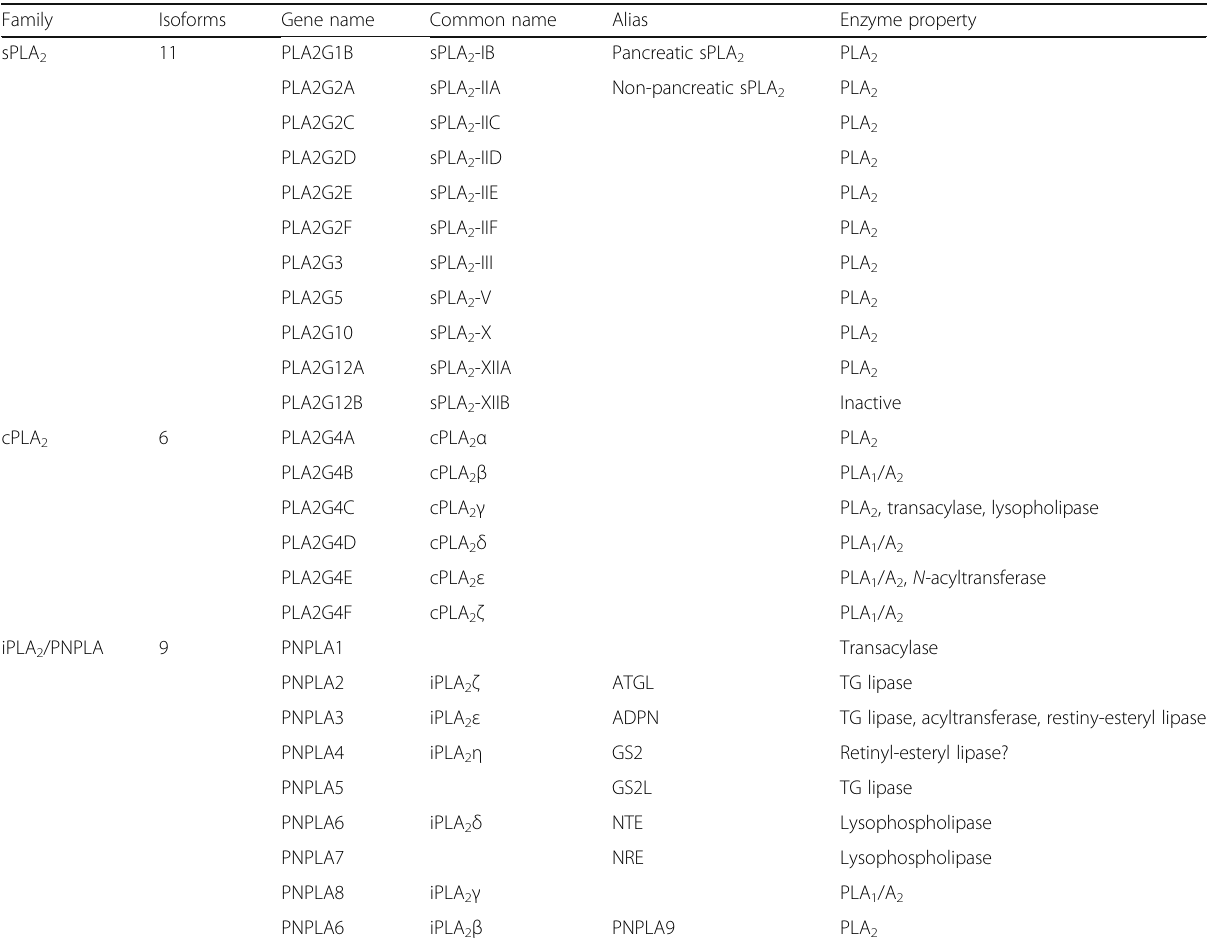
Table 1 The classification of PLA 2 family. sPLA 2 , cPLA 2 , and iPLA 2 /PNPLA are the original big three among the PLA 2 family. The sPLA 2 family contains 10 catalytically active isoforms (IB, IIA, IIC, IID, IIE, IIF, III, V, X, XIIA) and 1 inactive isoform (XIIB) in mammals. The cPLA 2 family comprises 6 isoforms ( α - ζ ). The human genome encodes 9 iPLA 2 enzymes. These enzymes are now more generally referred to as PNPLA (1 – 9). In this review, the biological roles of particular PLA 2 s in the context of skin homeostasis and diseases were